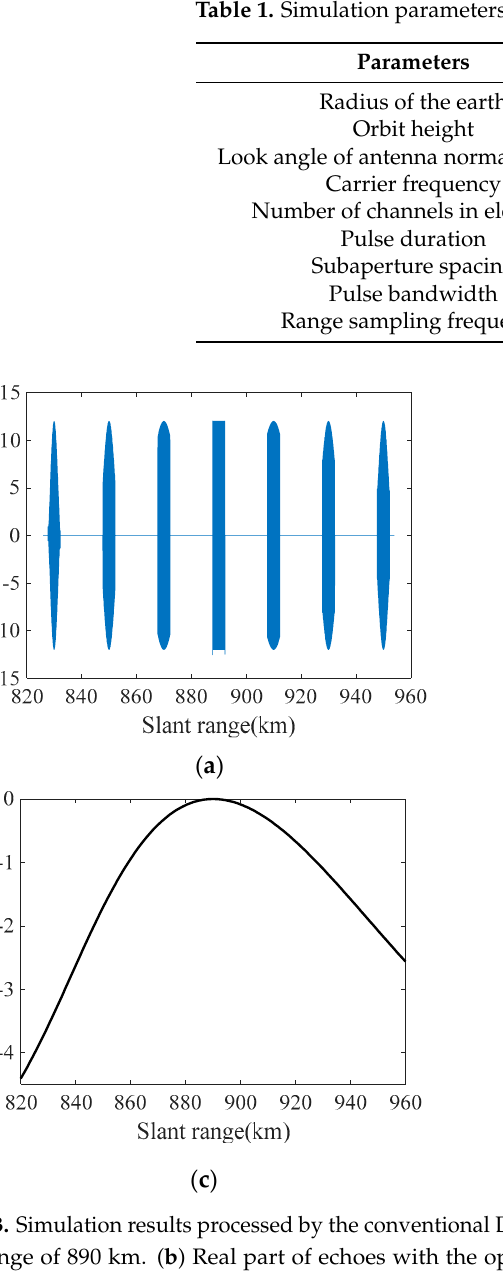
Table 1. Simulation parameters.